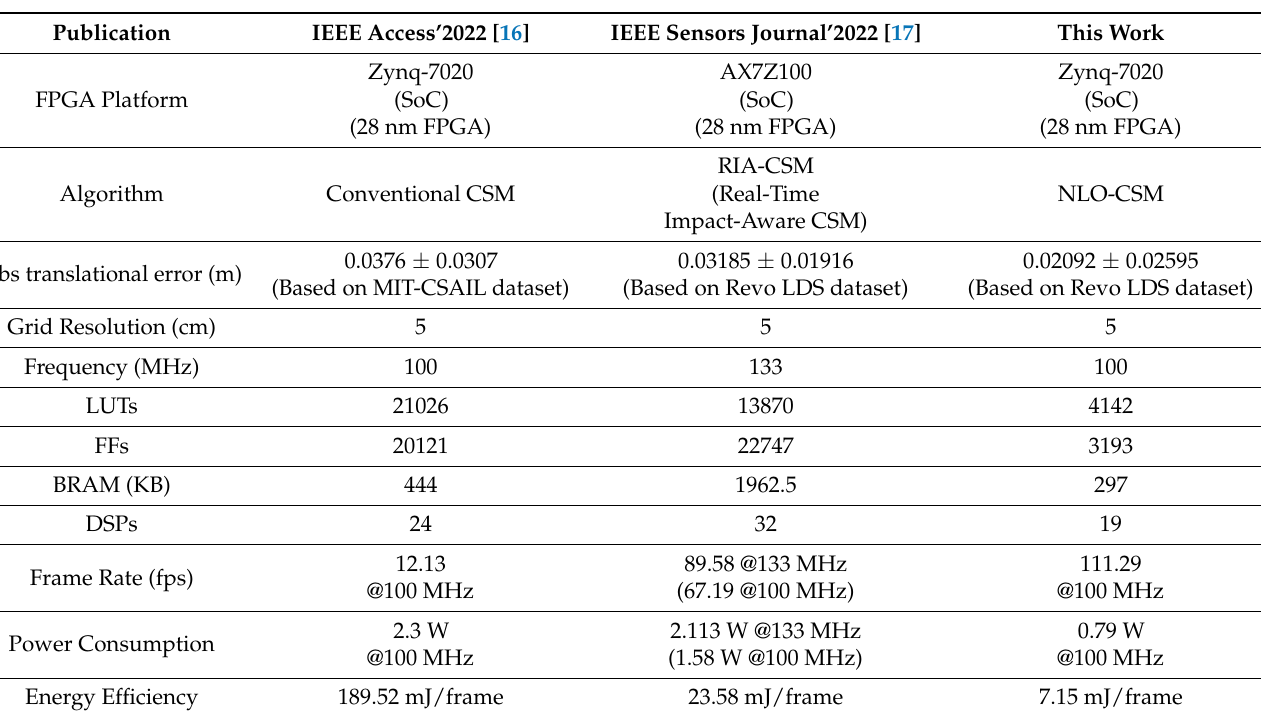
Table 5. The proposed NLO-CSM accelerator, based SoC’s characteristics and performance evaluation results, compared to the